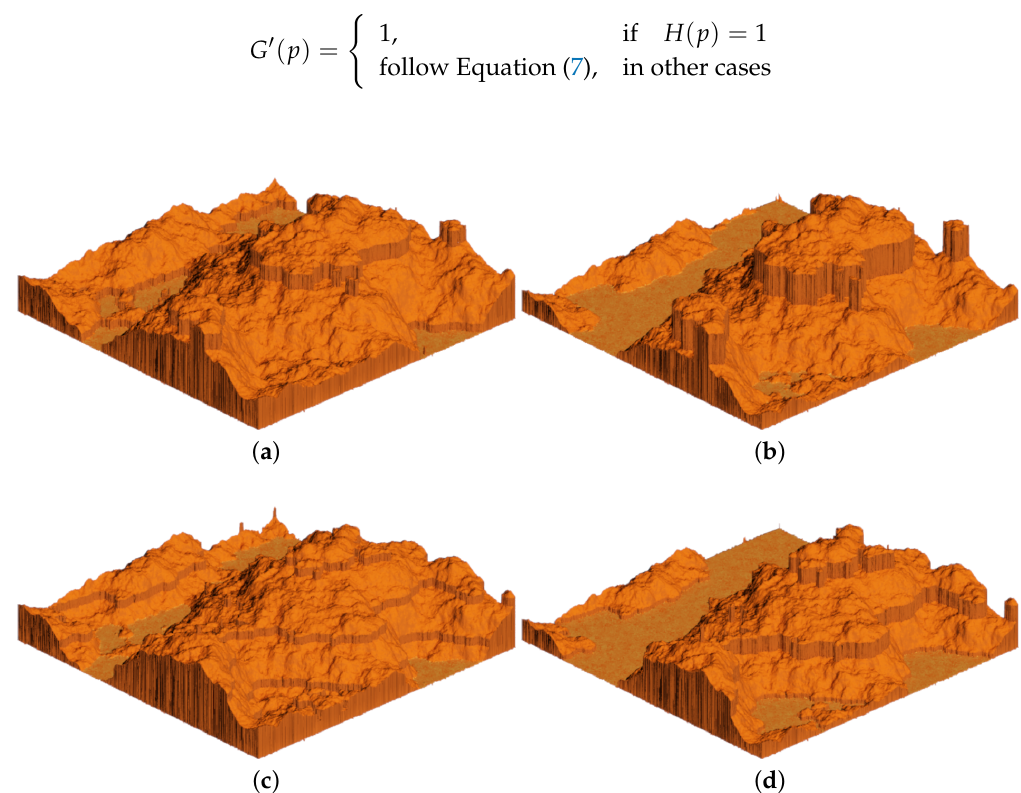
Figure 11. Comparison of the erosion impact on the sample mesa model shown in Figure 8. ( a ) E = 0.33, mat = 3. ( b ) E = 0.66, mat = 3. ( c ) E = 0.33, mat = 5. ( d ) E = 0.66, mat = 5.